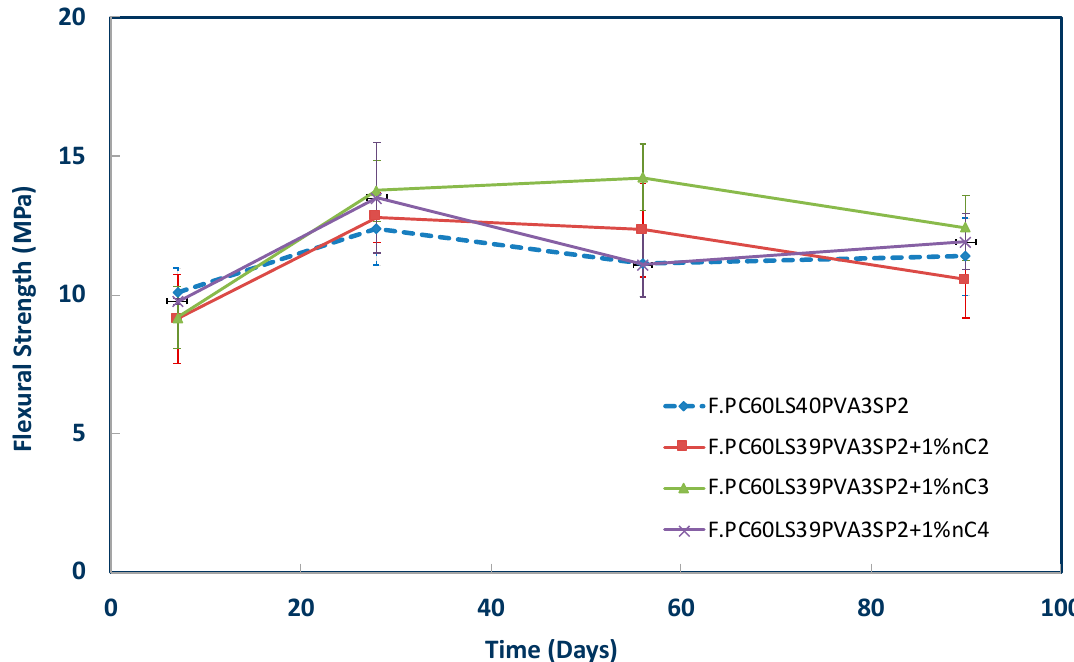
Figure 7. Flexural strength of 1% nC2, nC3 [28], and nC4 fiber–cement nanohybrids based on F.PC60LS40PVA3SP2.